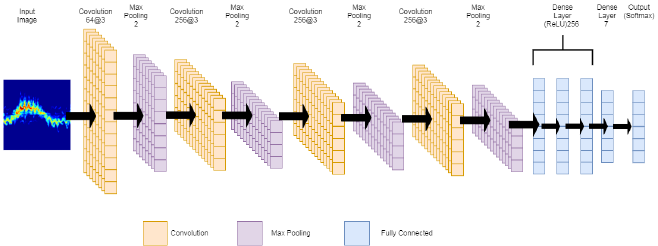
Figure 5. Visual representation of CNN model used in